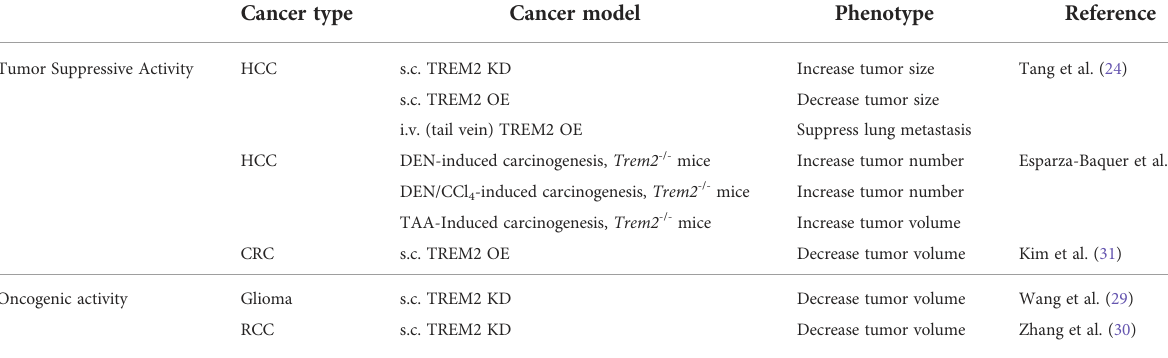
TABLE 2 Summary of mouse studies with supporting evidence for TREM2 contributing to tumor suppressing or oncogenic activity in different types of